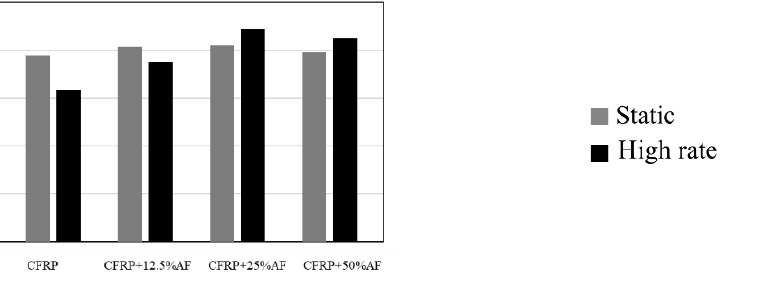
Figure 26. Failure load obtained for composite single lap joints with toughened adherends. Adapted from [156].